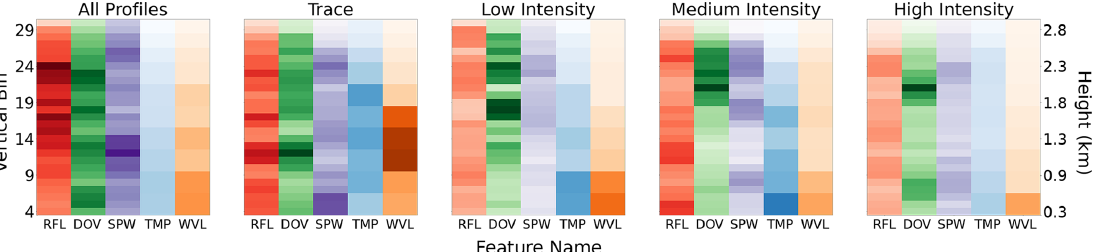
Figure 8. Normalized vertical column Shapley global feature importance values (i.e. | SHAP DP | ). Shapley output values are calculated for different subsets of vertical column reflectivities separated into all profiles, trace intensity, low intensity, medium intensity, and high intensity precipitation events based on a k -means clustering of input data (more in Sect. 3.2). Areas of dark color indicate a high feature importance at that location within the vertical